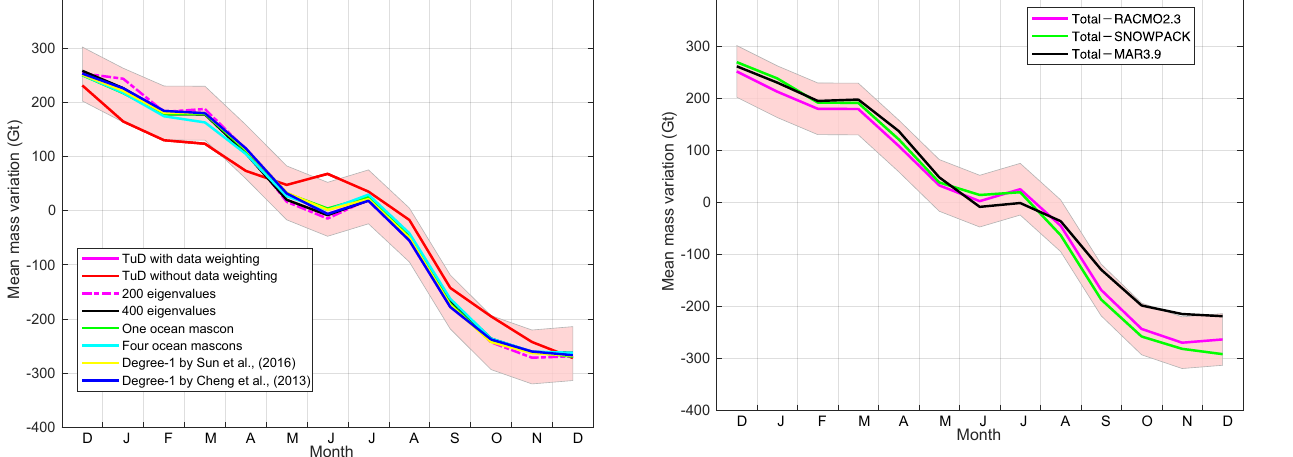
Figure A3. The mean mass anomalies per calendar month of the total–SMB residuals over the entirety of Greenland estimated by applying different GRACE data processing schemes.